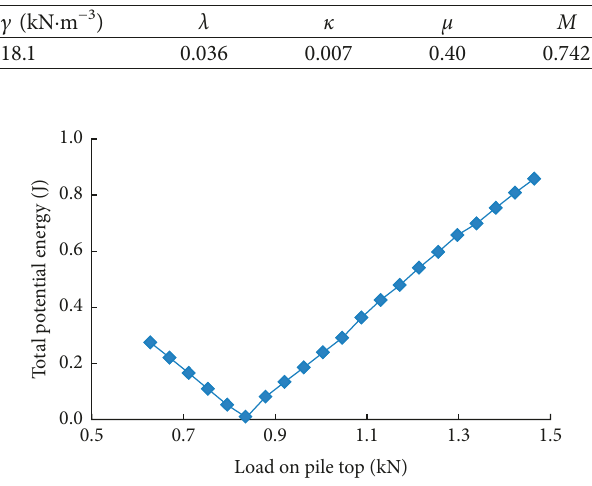
Figure 6: Energy with load on pile top.